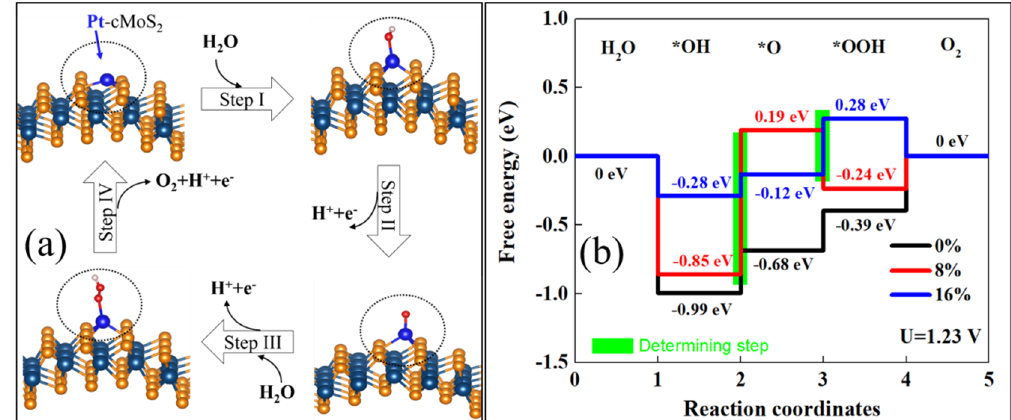
Figure 7. ( a ) Proposed 4e-mechanism of oxygen evolution reaction on Pt@cMoS 2 . ( b ) Gibbs free-energy diagram for the four steps of OER on Pt@cMoS 2 at different curvatures. The green box step is the rate determining.